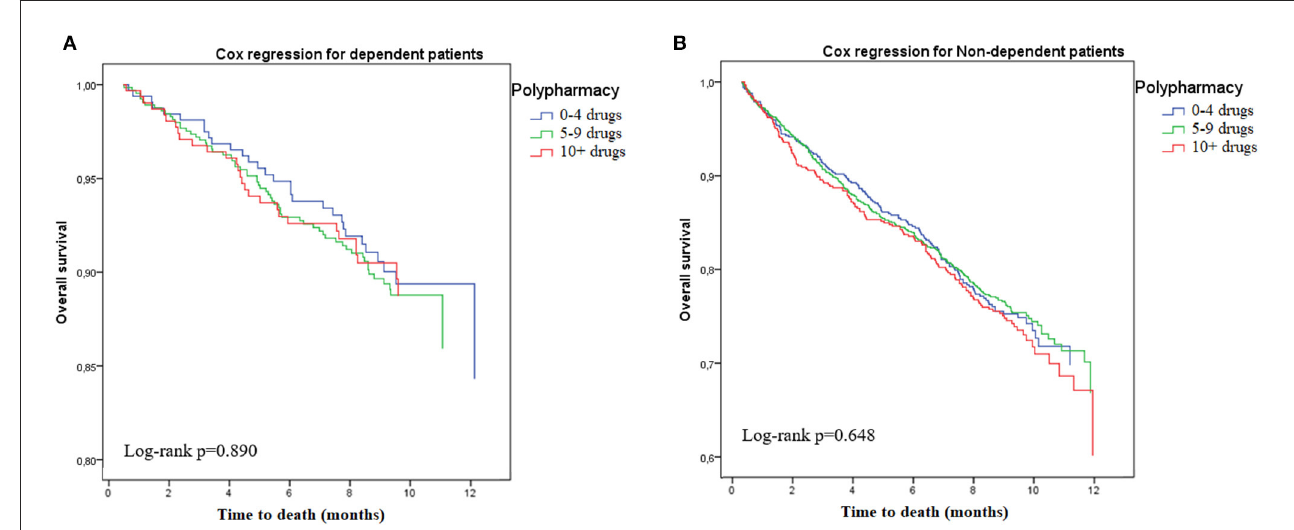
FIGURE1 Risk of death according to polypharmacy status, stratified by disability. (A) Dependent. (B) Non-dependent.